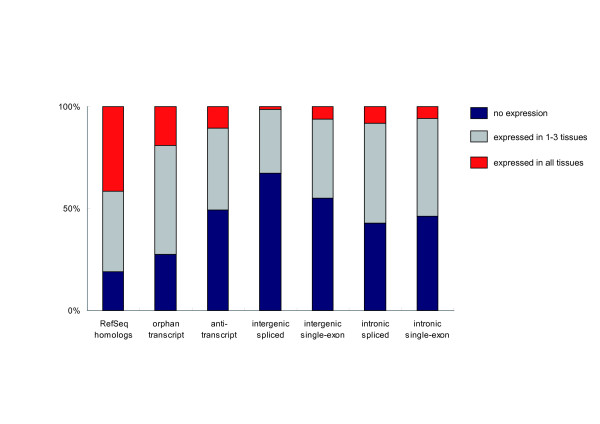
The proportion of the expressed transcripts in the RefSeq homologs (control) and unidentified transcripts. Cerebrum, cerebellum, liver, and testis of a male macaque were used for the microarray experiments with duplicated hybridizations. The transcripts were classified into no expression (blue), expressed in 1–3 tissues (grey), or expressed in all tissues (red).